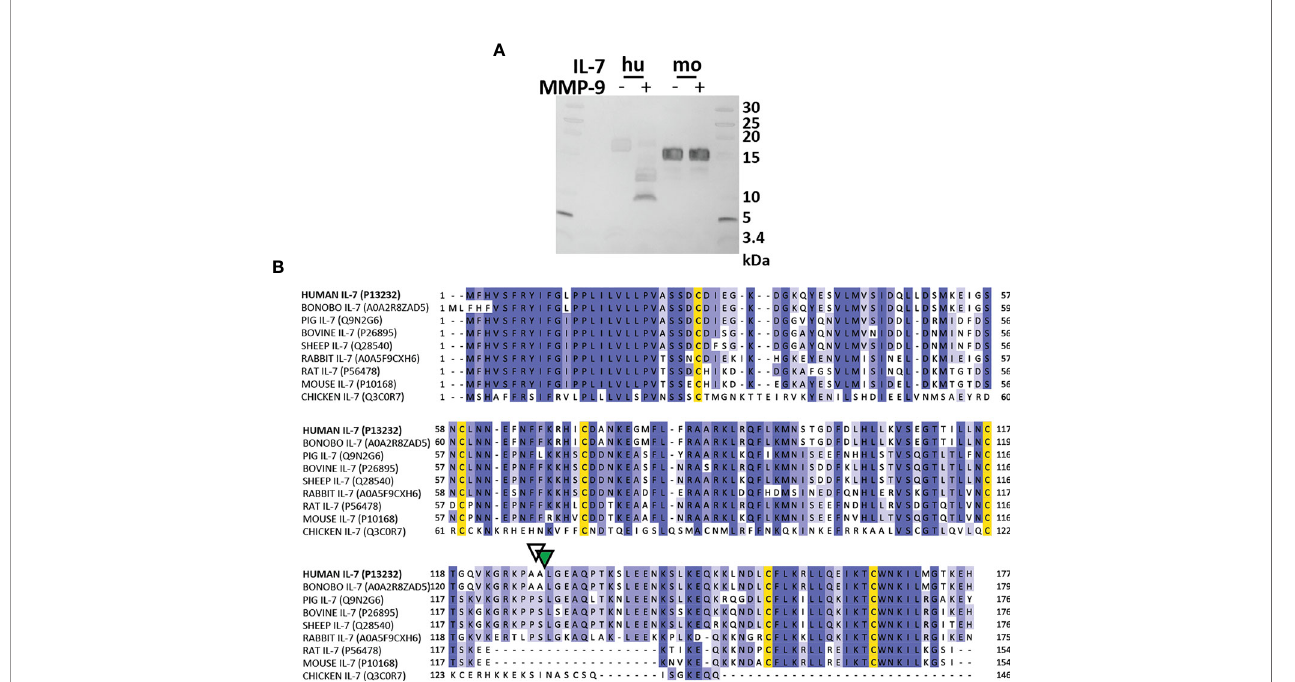
FIGURE 6 | Mouse IL-7 lacks the protease-susceptible loop region and is not cleaved by MMP-9. (A) Incubation of recombinant human (hu, insect cell-derived) and (mo, E. coli -derived) IL-7 with active MMP-9 and analysis of the reaction products by reducing SDS-PAGE. (B) Alignment of the amino acid sequence of human, bonobo, pig, bovine, sheep, rabbit, rat, mouse and chicken IL-7 with indication of the MMP-9 (green triangle) and serine protease (white triangle) cleavage sites in human IL-7. Multiple sequence alignment was performed with ClustalO, with relative amino acid sequence conservations indicated in various shades of blue and conserved cysteine residues in yellow. Notice the missing sequences in mouse and rat IL-7 and a different sequence in chicken IL-7 in the area which represents the protease-sensitive